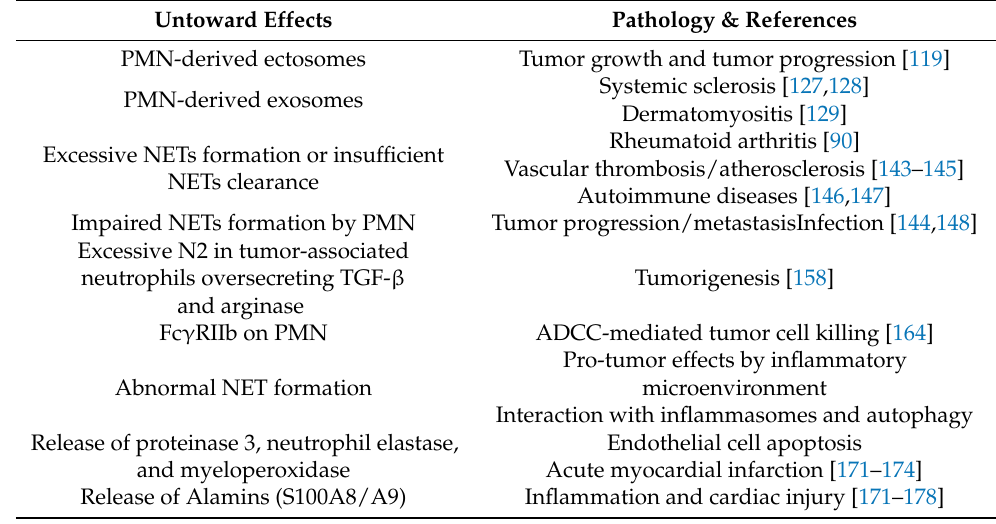
Table 4. Untoward effects of deranged PMN functions in clinical practice. Untoward